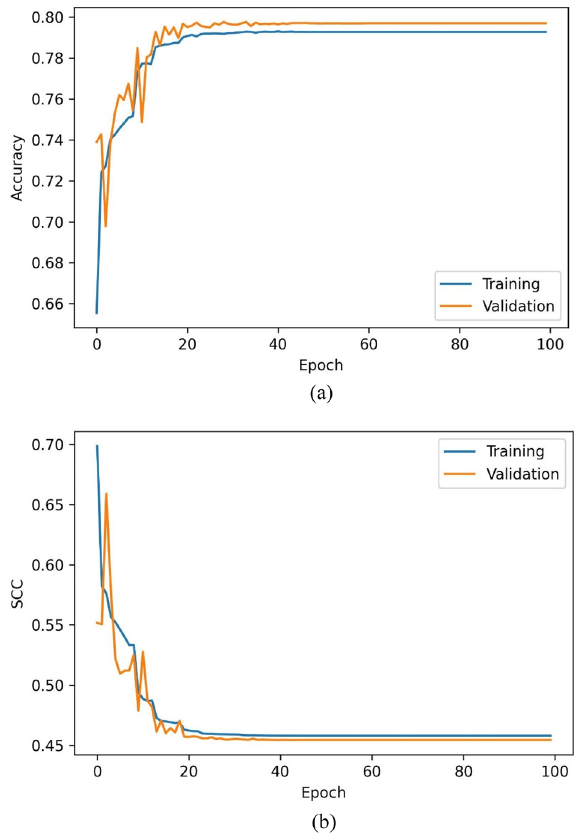
Figure 11. Training ( a ) accuracy and ( b ) SCC of the C 02